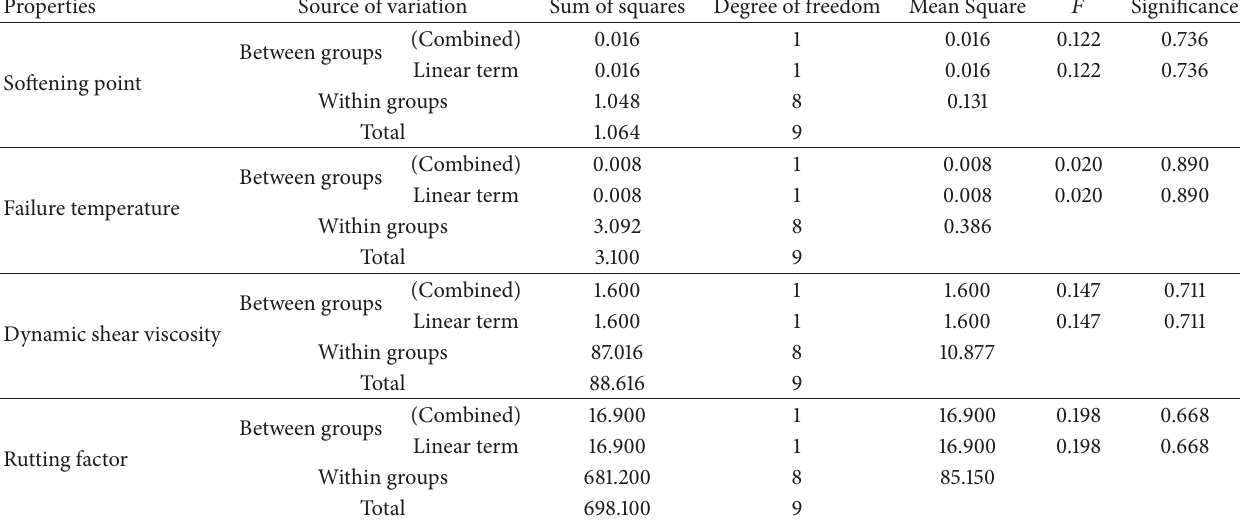
Table 3: ANOVA: single factor between the TiO 2 -50 and TiO 2 -100 groups.